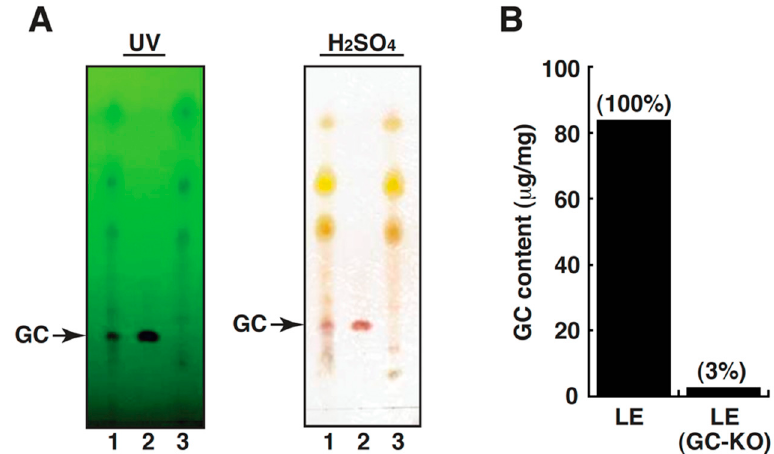
Figure 2. Preparation and characterization of licorice extract (LE) and glycyrrhizin (GC)-free licorice extract (LE / GC-knockout (KO)). ( A ) Thin layer chromatography (TLC) profiling of LE, LE / GC-KO